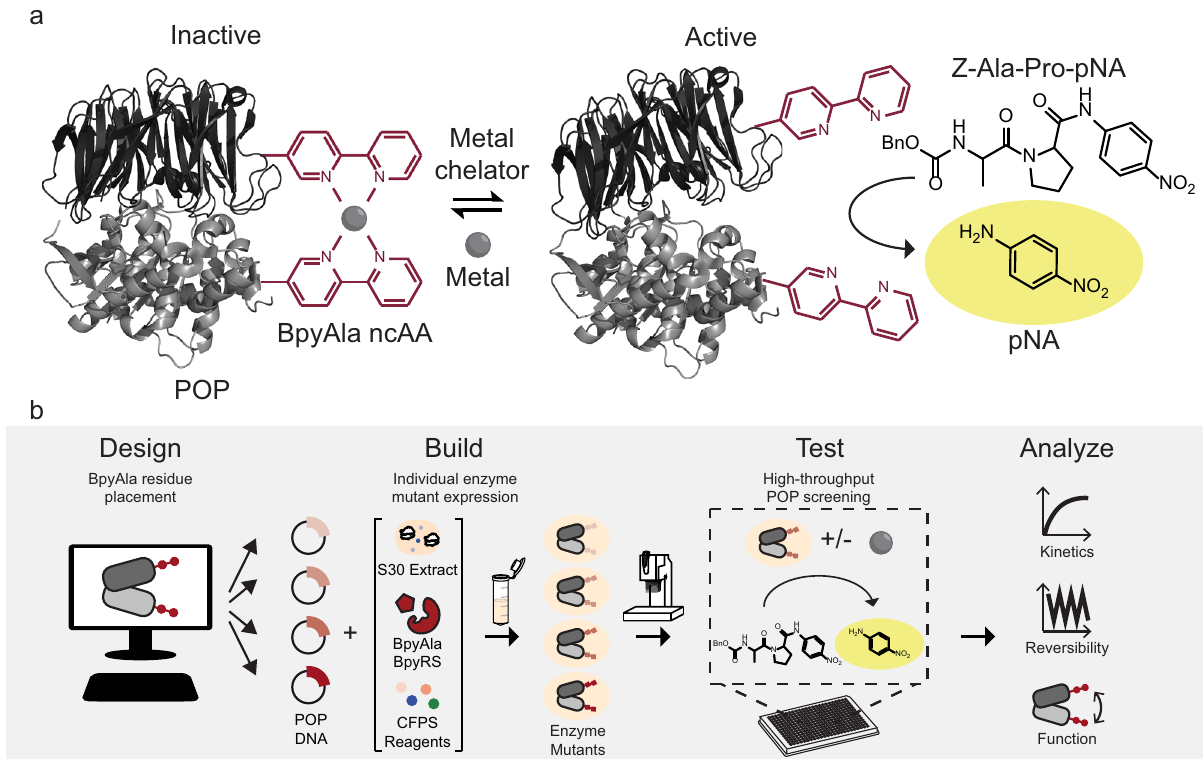
Fig. 1 Development of BpyAla LG protein switches. a Reversible metal regulation of Pfu prolyl oligopeptidase (POP) via bis-bidentate metal binding by a BpyAla LG pair. b Work fl ow for engineering LG protein